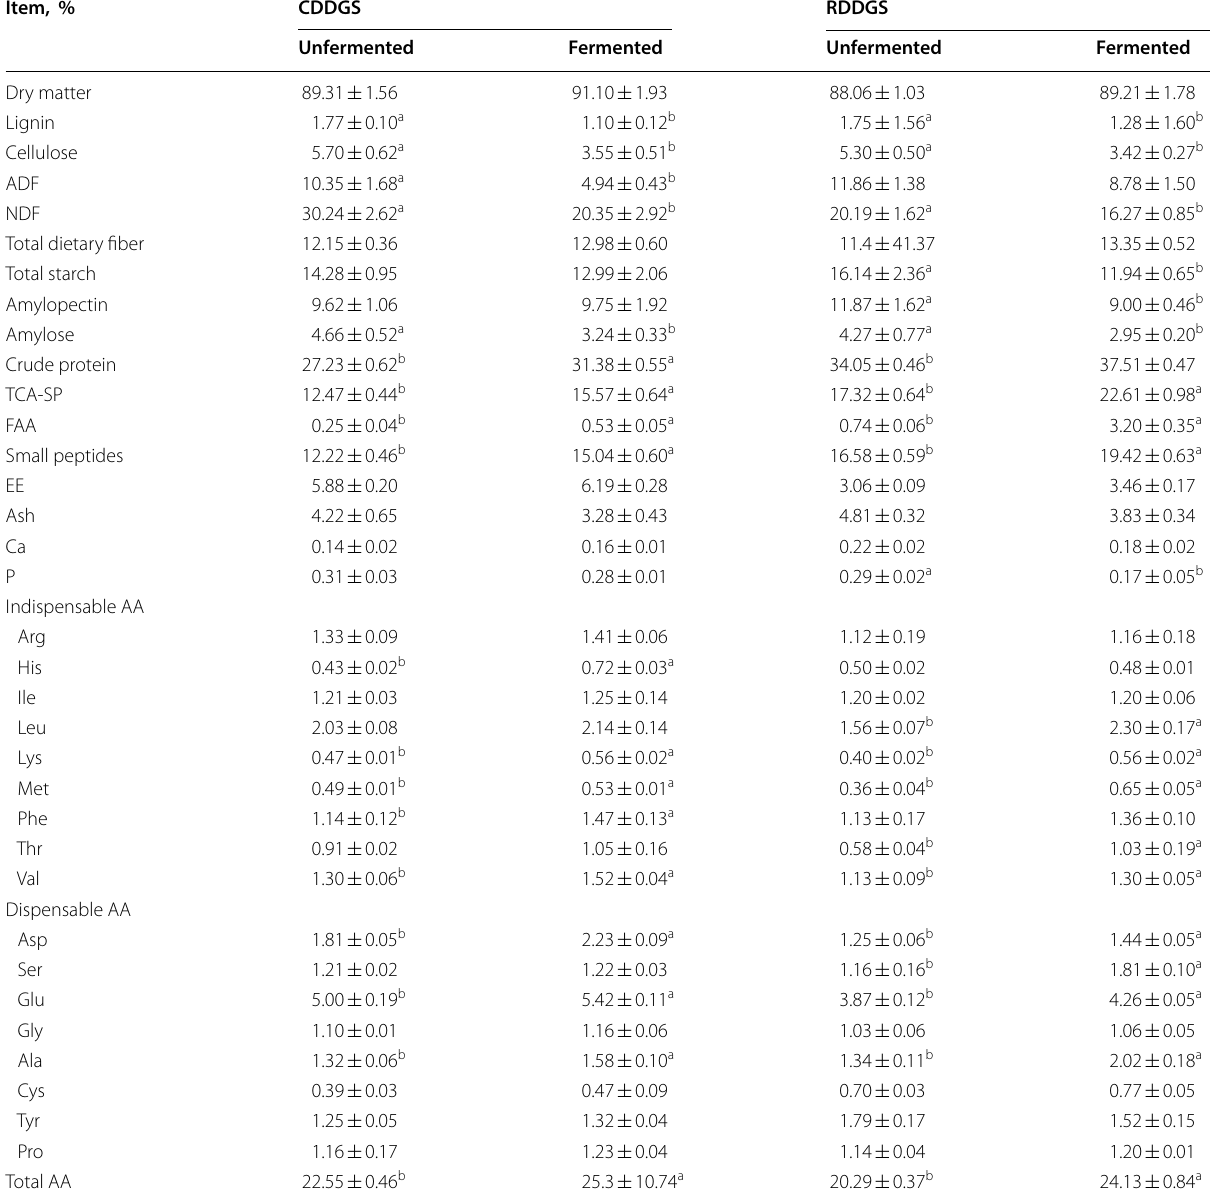
Values are means of three replicates per treatment. Means in a row without common superscript differ significantly ( P <